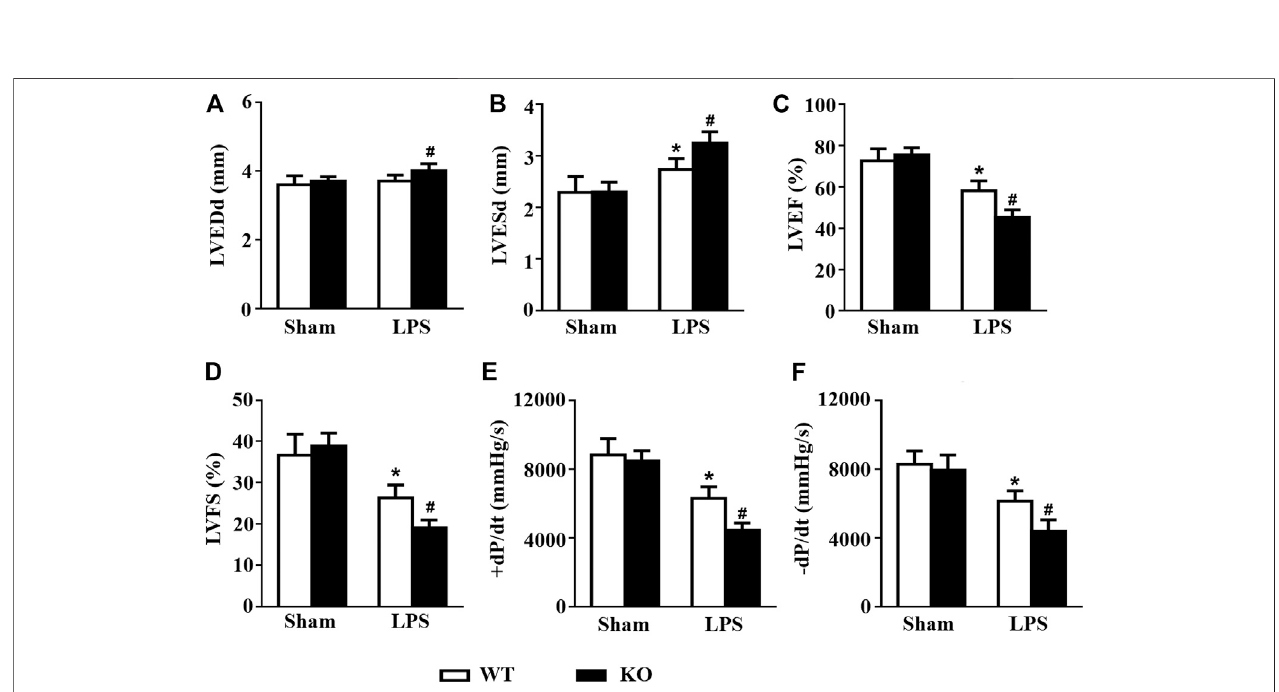
FIGURE 3 | Il12a deletion exacerbates LPS-induced cardiac dysfunction. (A – D) Echocardiographic analysis of LVEDd, LVESd, LVEF and LVFS in each group (n (cid:1) 8). (D – E) Hemodynamic analysis of +dP/dt and -dP/dt in each group (n = 6) . * p < 0.05 compared with the sham + WT group; # p < 0.05 compared with the LPS + WT group.